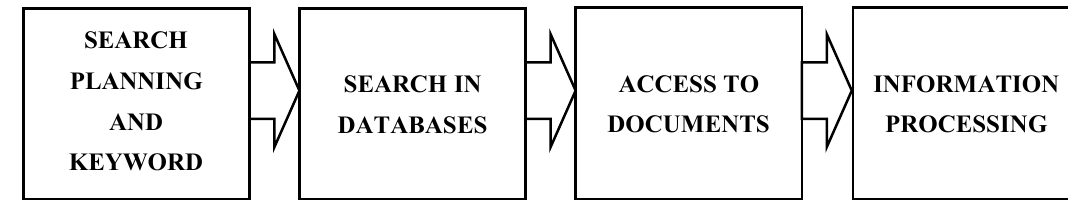
Figure 1. Diagram of the literature search